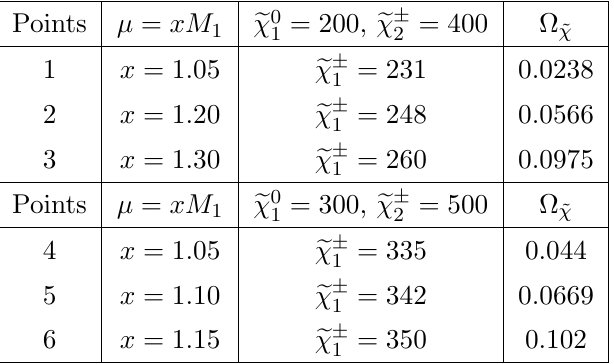
(cid:31) (cid:6) masses in relaxed compression scenario. All e 2